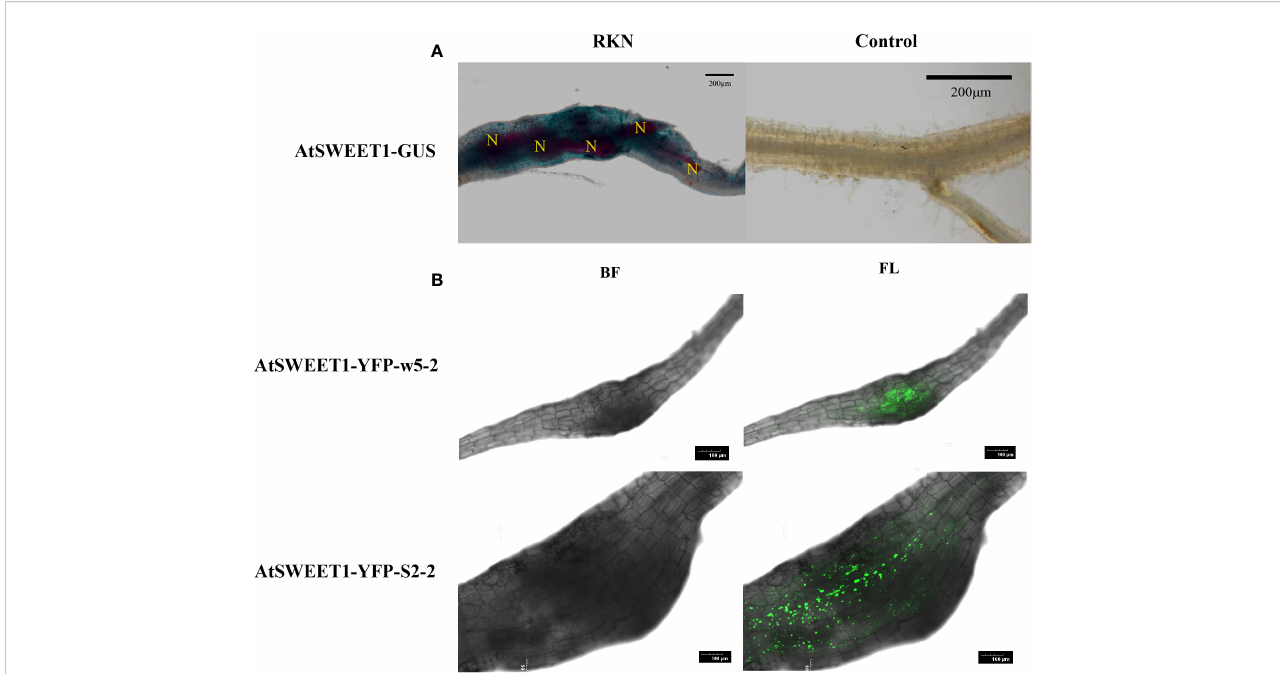
FIGURE 2 AtSWEET1 expression is induced speci fi cally at the galls in roots. (A) Histochemical GUS assay of AtSWEET1-GUS lines infected with J2 of M. incognita at 18 dpi. Strong GUS activity in the nematode feeding sites of AtSWEET1-GUS but no GUS activity in the root of no nematode-infected AtSWEET1-GUS lines was observed. N, nematode. Scale bars=200 m m. (B) The LSCM micrographs of A. thaliana complemented (AtSWEET1-YFP-w5-2 and AtSWEET1- YFP-S2-2) plants inoculated with M. incognita . Scale bars=100 m